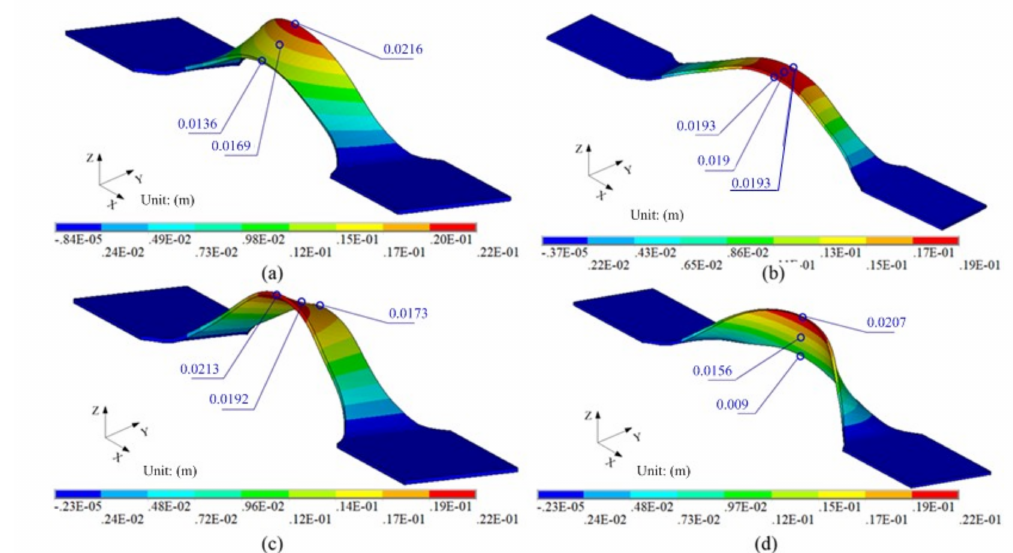
Figure 9. Effect of relative position on final shape: ( a ) h = 14.5 mm, ( b ) h = 9.45 mm, ( c ) h = 7.25 mm, ( d ) h = 0 mm.